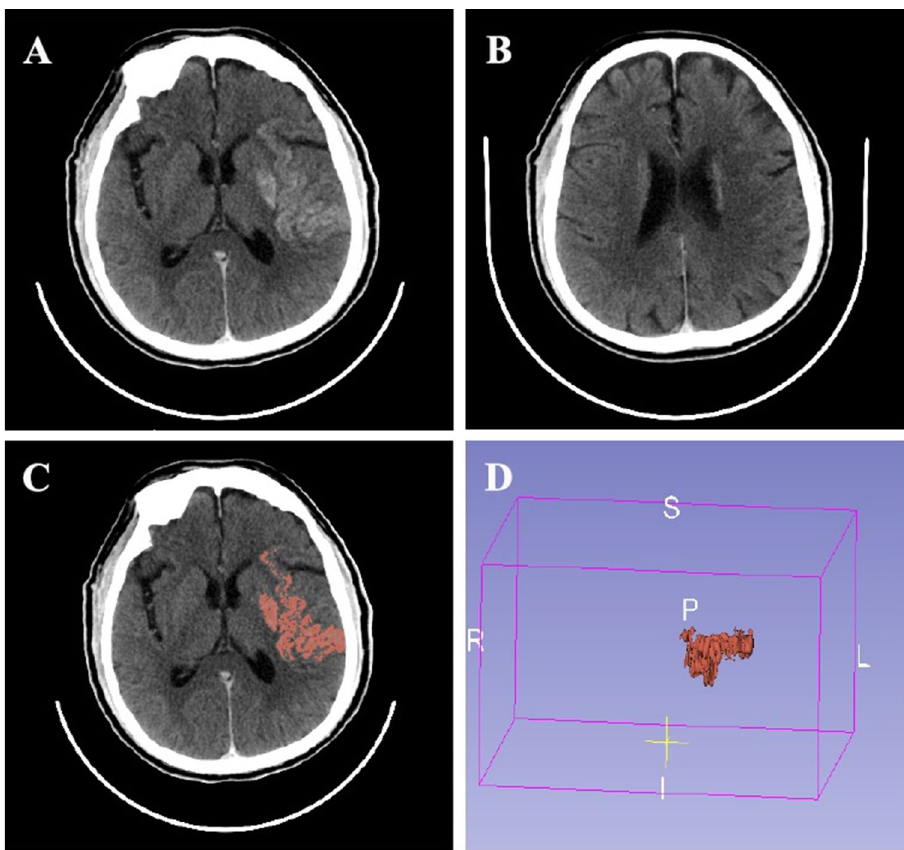
Figure 1. A 71-year-old patient presented with left-sided weakness (CE-ASPECT 6 and CE-Volume 9.041 ml). ( A ) and ( B ) Showing CE in the insula, lenticular nucleus, M1 and M2 ASPECTS regions. Thus, the CE-ASPECTS was counted as 6. ( C ) and ( D ) The three-dimensional structure of CE in the brain was reconstructed with a volume of 9.041